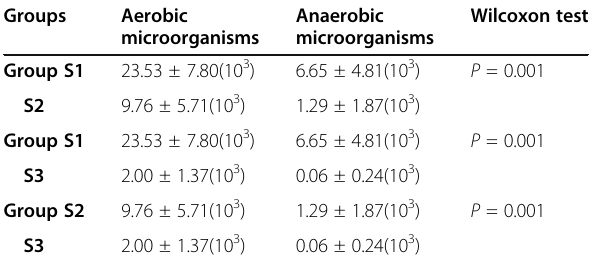
Table 6 Pairwise comparison of the mean colony-forming units of aerobic and anaerobic microorganisms between the groups Groups